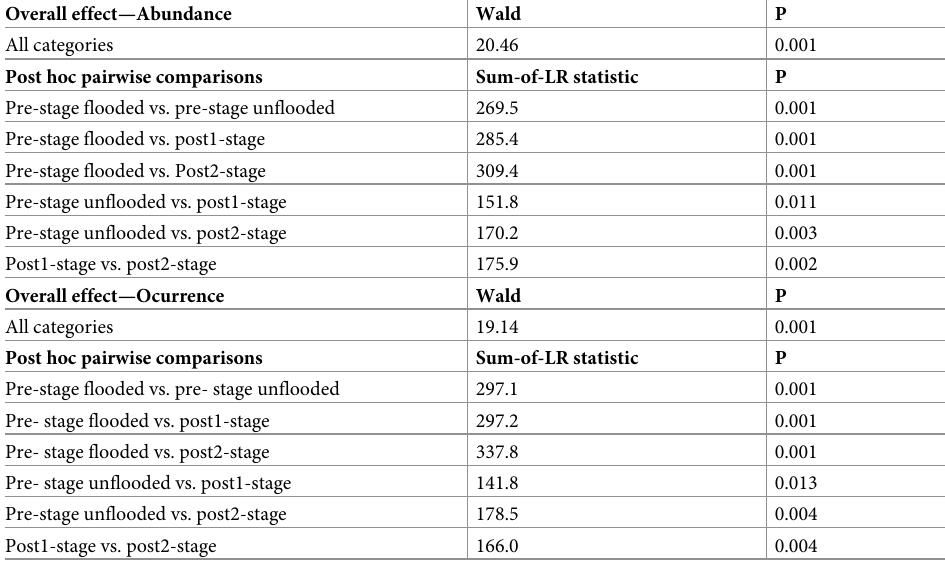
Table 1. Manyglm analysis of the association between the structure of frog assemblages in flooded and unflooded plots around the Madeira River, southwestern Brazilian Amazonia in relation to inundation and time before or after dam